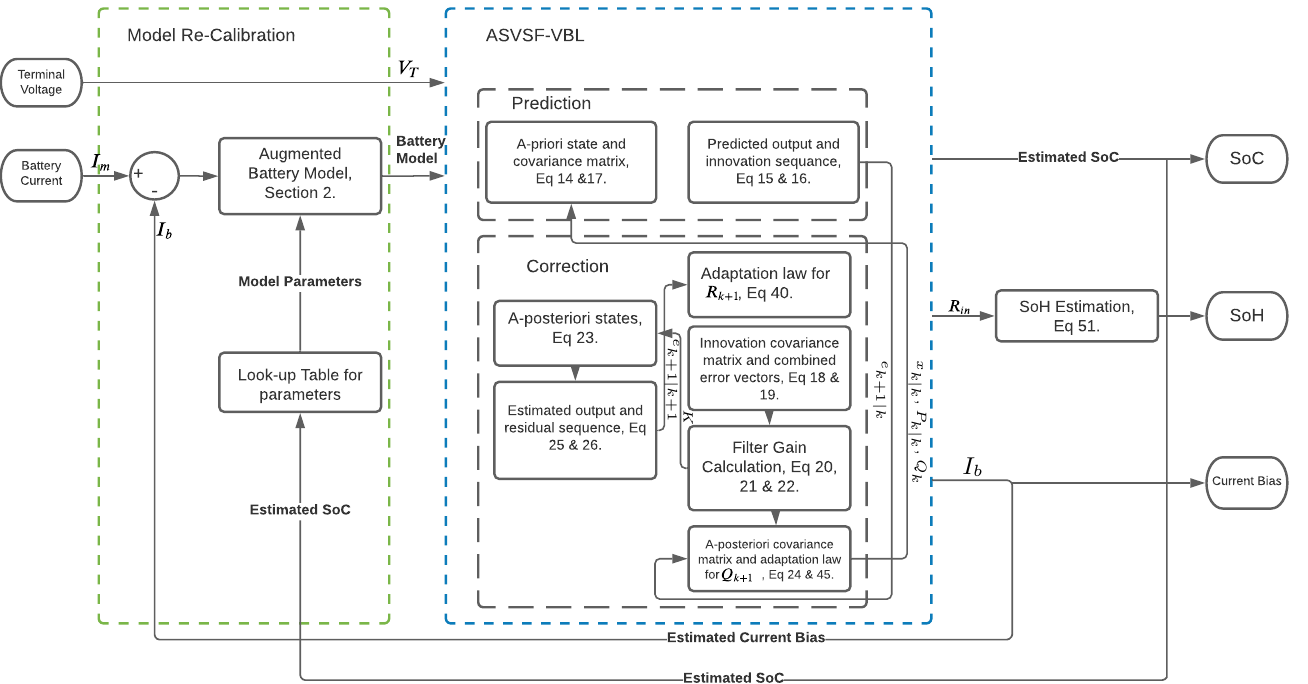
Figure 4. An overview of the proposed strategy for battery state estimation.